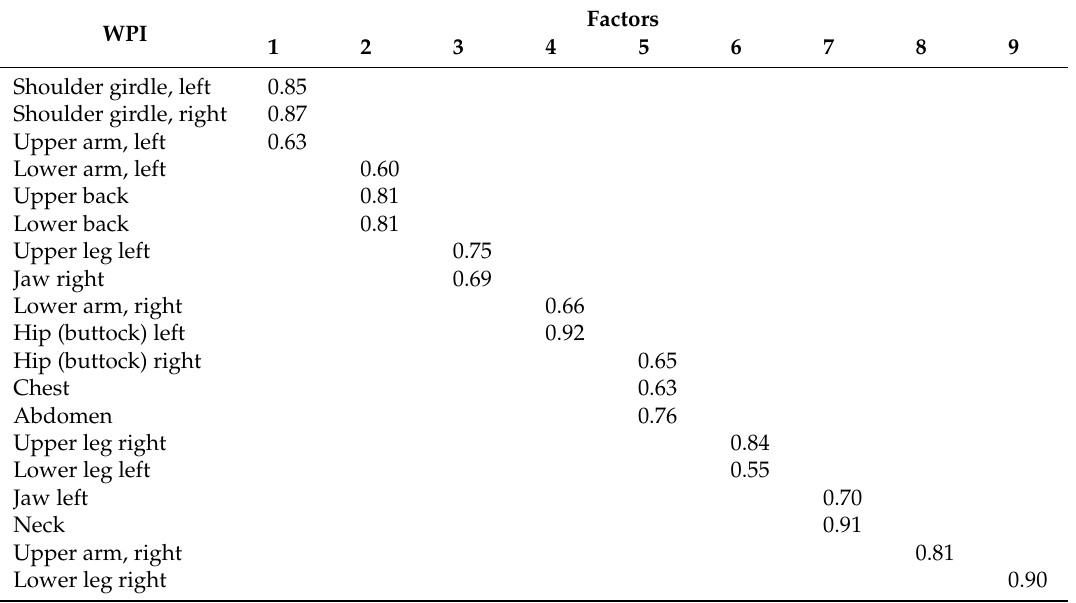
Table 2. Factor load matrix for confirmatory factor analysis (CFA) of WPI (Varimax